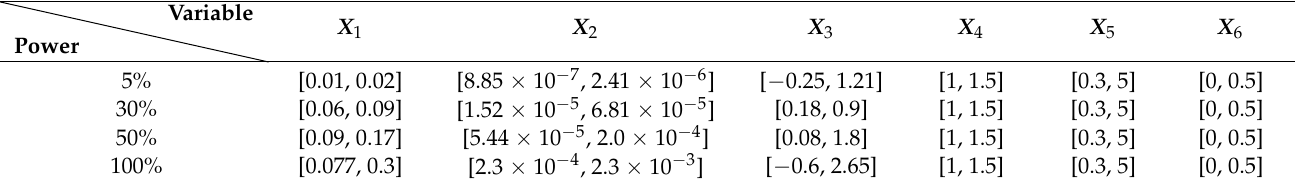
Table 1. Controller parameters settings of the cascade PID control